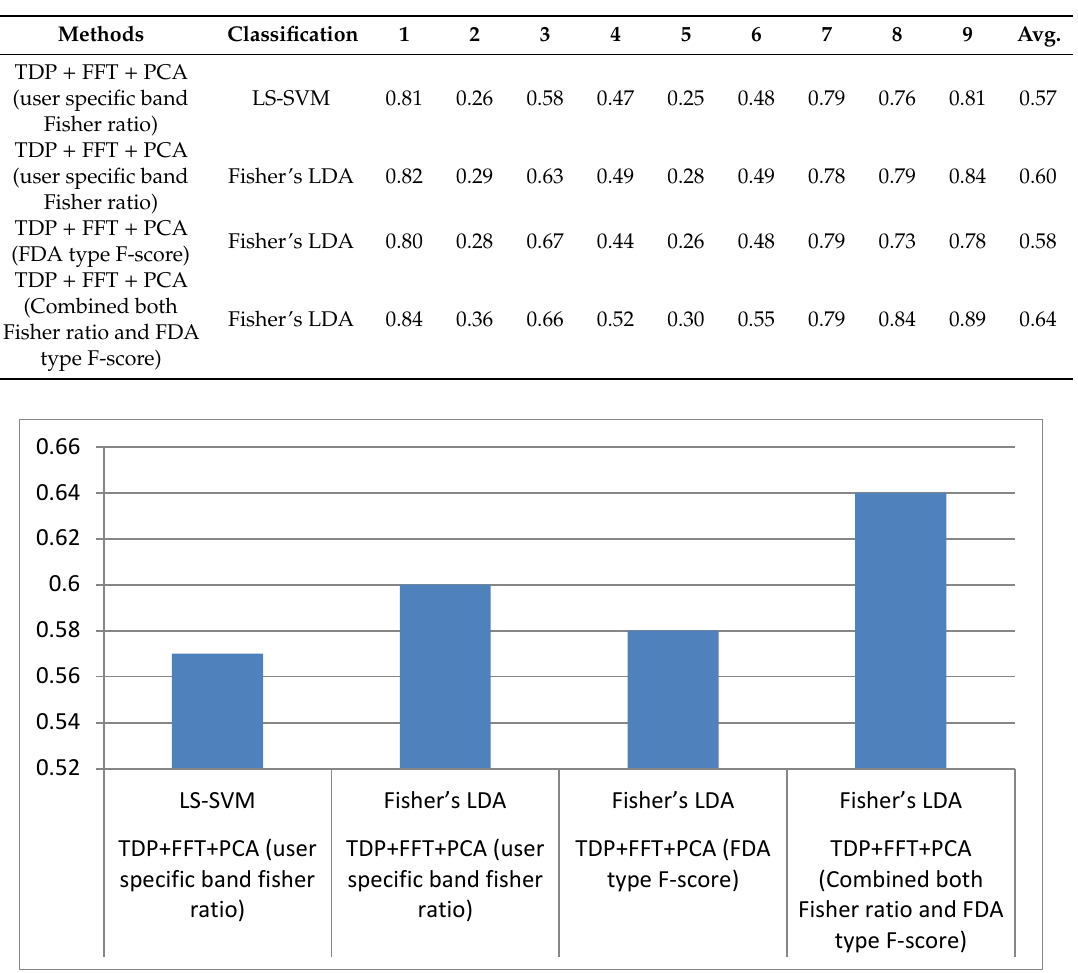
Figure 8. Comparison of the proposed method with other combinations.